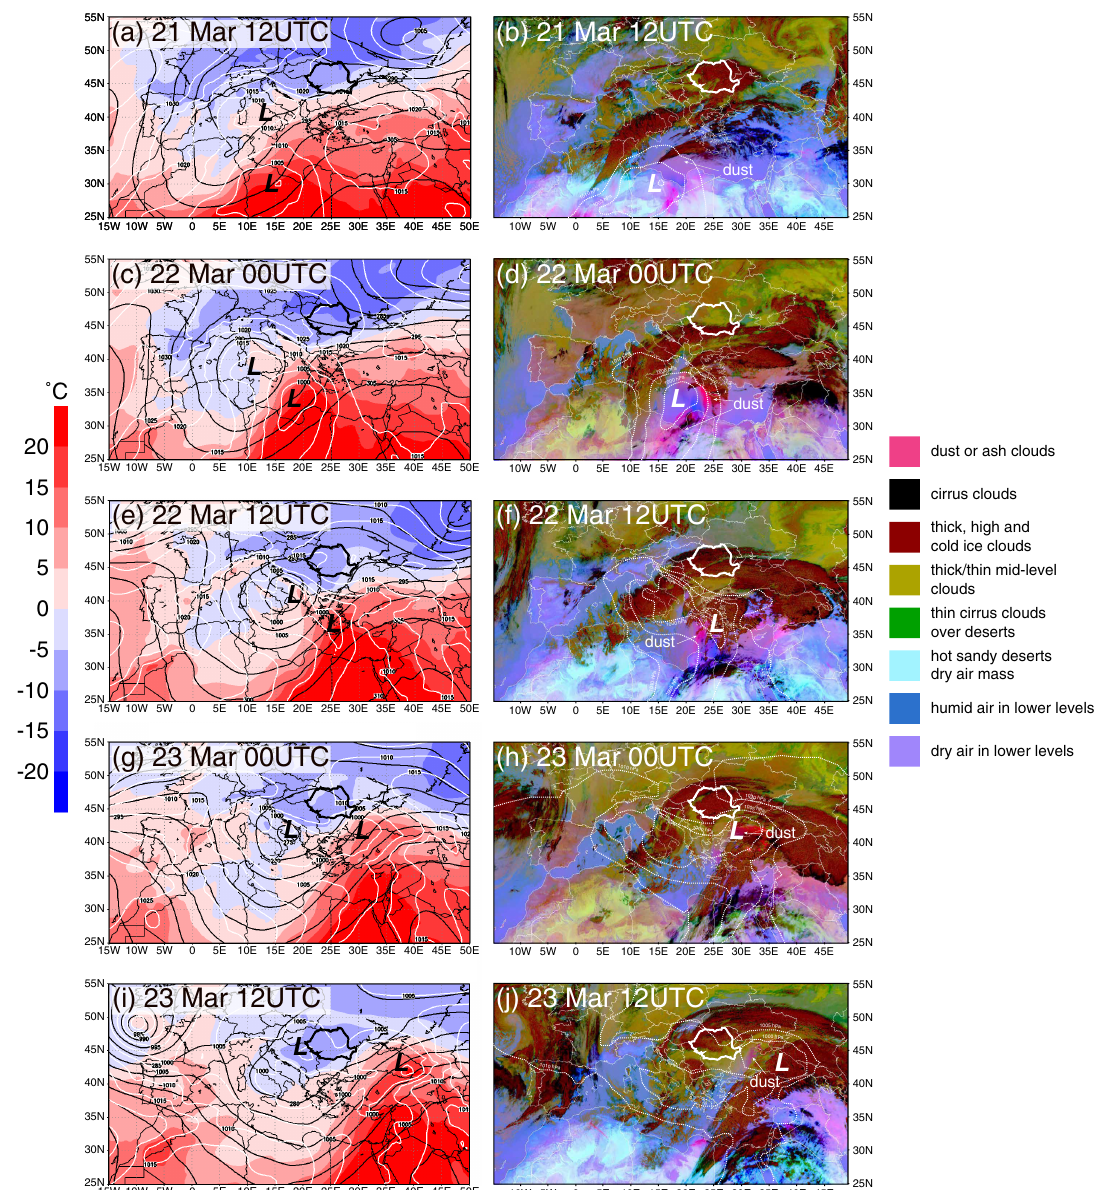
Figure 4. The evolution of the dust event between 21–23 March (every 12 h), starting from 21 March 1200UTC ( a , b ) and ending on 23 March 1200UTC ( i , j ). The left panels show mean sea level pressure (white contours, every 5 hPa), 700 hPa geopotential height (black contours, every 5 gdam) and temperature at 850 hPa (shaded according to the scale) retrieved from ERA-Interim. The right panels show MSG-SEVIRI dust RGB images and the sea level pressure (white contours, every 5 hPa) from